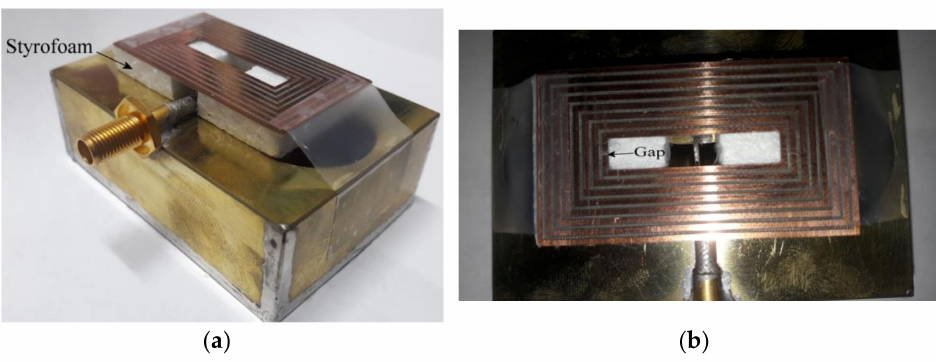
Figure 15. Prototype: ( a ) isometric view, ( b ) top view of rectangular rings.